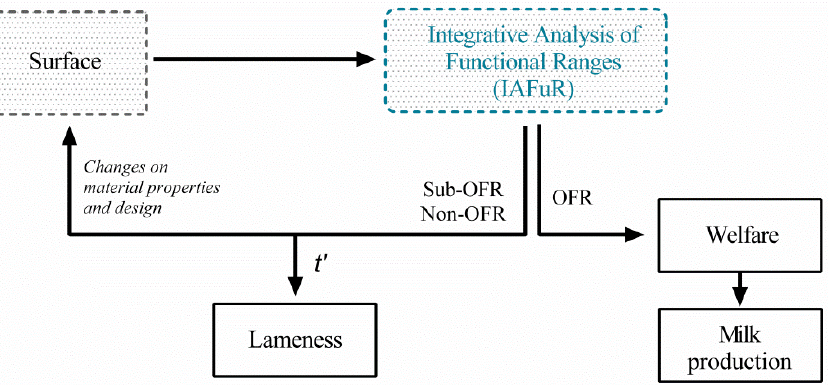
Figure 5. Decision-making processes in bovine lameness by an adaptable strategy based on an integrative analysis of functional ranges. The conventional surfaces’ (i.e., grass, sand, rubber, asphalt, and concrete) impact on the movement parameters (i.e., posture, kinematics, kinetics, and behavior) is evaluated by the IAFuR. The information of movement capacities drives two possibilities of decision making: (i) for optimal functional ranges of all movement capacities, a state of wellbeing with high production is favored and (ii) for suboptimal and non-optimal functional ranges, it is necessary to develop a new alternative surface by evaluating specific material and design properties for the animal’s requirements. This external factor changes (i.e., surface’s engineering) will modify the internal state (i.e., lameness risk over time), capacities, and pathway of the animal’s movement, which will be evaluated by a new IAFuR decision-making process. OFR: optimal functional range; sub-OFR: suboptimal functional range; non-OFR: non-optimal functional range; t’: sub-OFR and non-OFR over time.